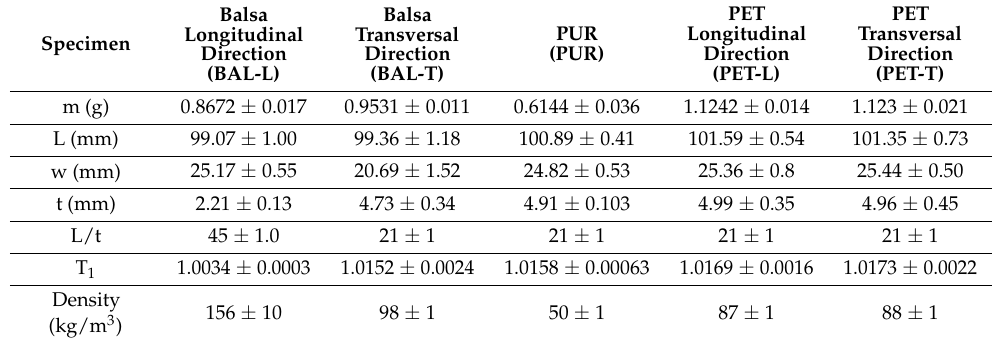
Table 2. IET test specimens’ physical characteristics and dimensions (the mean and the standard deviation of three test specimens).